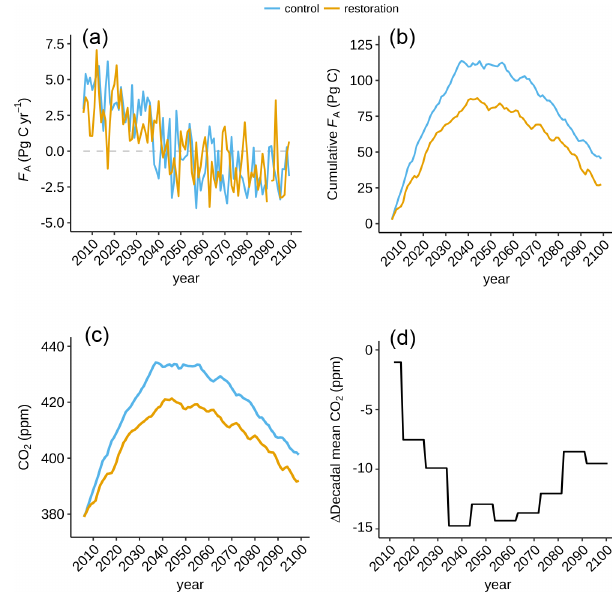
Figure 5. Impact of tropical land-use stop on net carbon flux into the atmosphere and CO 2 , (a) Net carbon flux into the atmosphere ( F A ), (b) cumulative F A , (c) atmospheric CO 2 for restoration (yellow) and control (blue) simulation, and (d) decadally averaged CO 2 dif- ference between the simulations. Note the different vertical